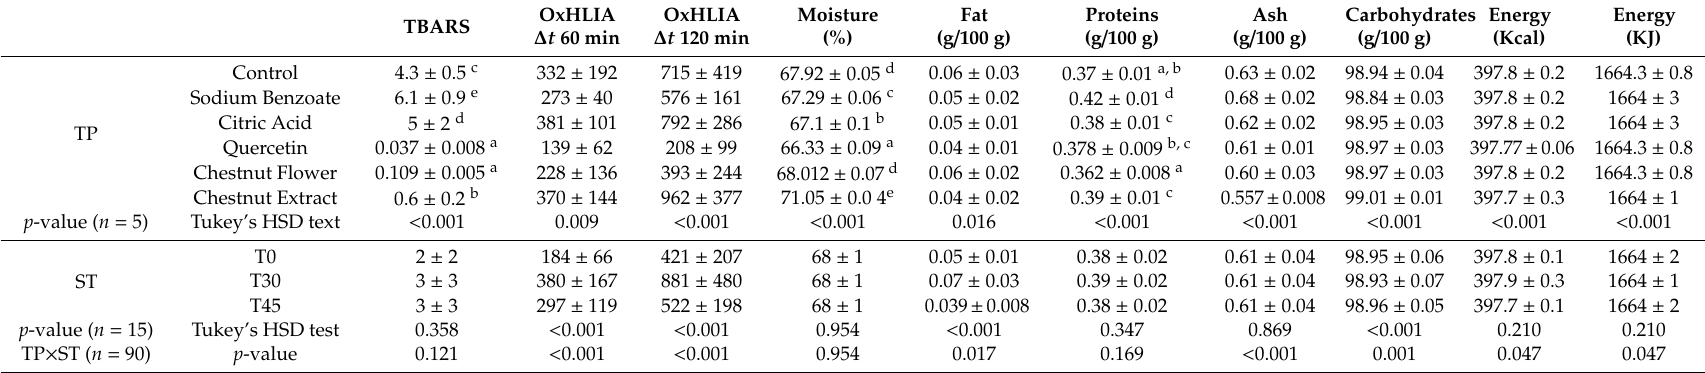
Table 1. Antioxidant and nutritional profiles of the di ff erent nutraceutical formulations. The antioxidant analysis (left of the vertical dashed line) are expressed in mg and µ g / mL of extract, respectively, while the nutritional value (right of dashed line) is expressed in fresh